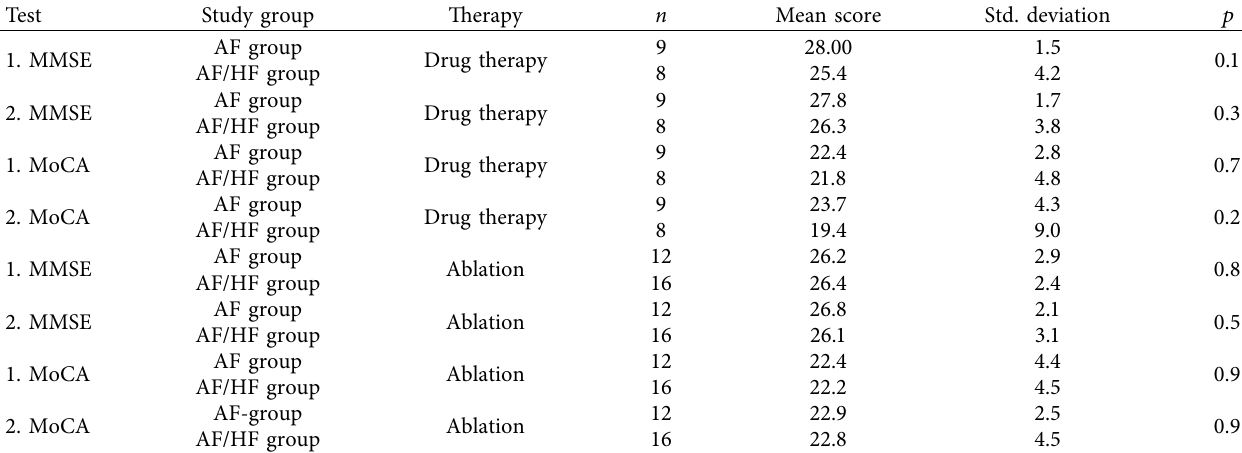
AF � atrial fibrillation, HF � heart failure, and SD � standard deviation.